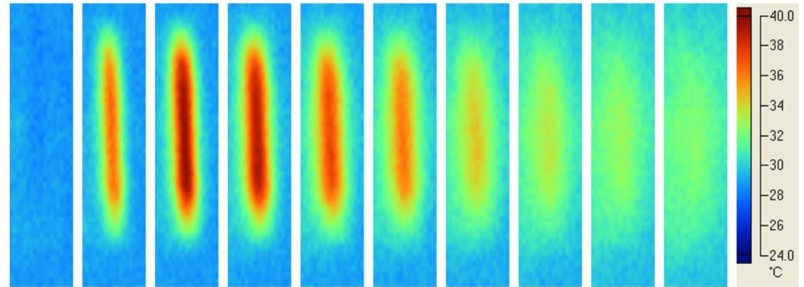
Figure 7. Light curing of SDR composite: typical temperature profiles using Mode II and blue LED Enfis curing unit. The almost uniform distribution of temperature along the whole specimen length suggested a uniform polymerisation of the specimen. Photograms were taken every 4 s.